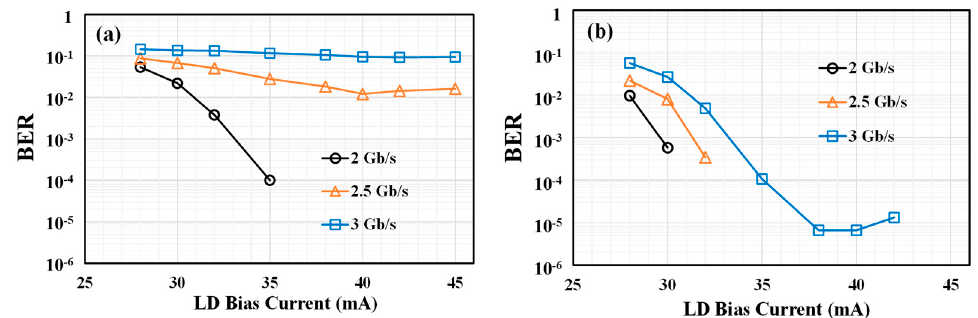
Figure 4. BER vs. LD bias current for various bitrate using ( a ) symbol by symbol detection and ( b ) 7-tap MLSE detection.